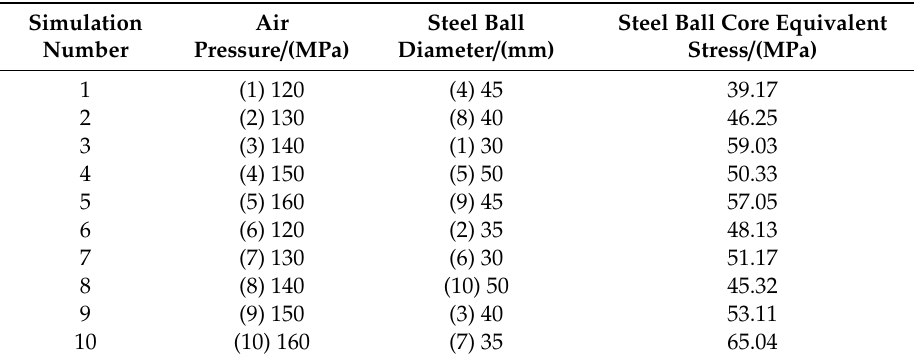
Table 2 were obtained by taking the minimum equivalent stress value near the inner void of the steel ball as the index. Table 2. Simulation